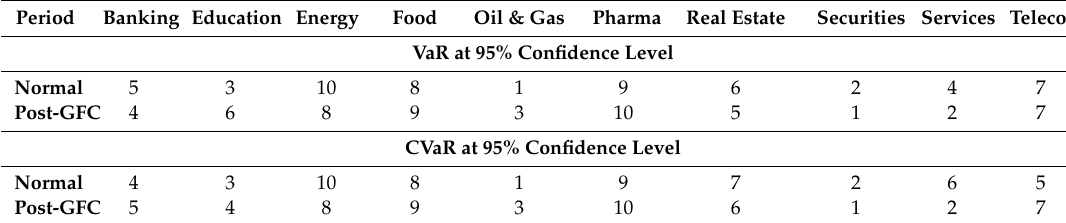
Table 3. Sub-sample ranking of ten industries, 2009–2017.